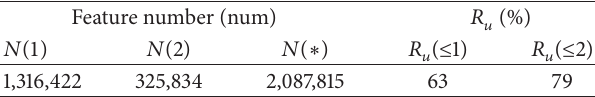
Table2:FeaturenumberanduselessnessrateinTanCorpcollection.